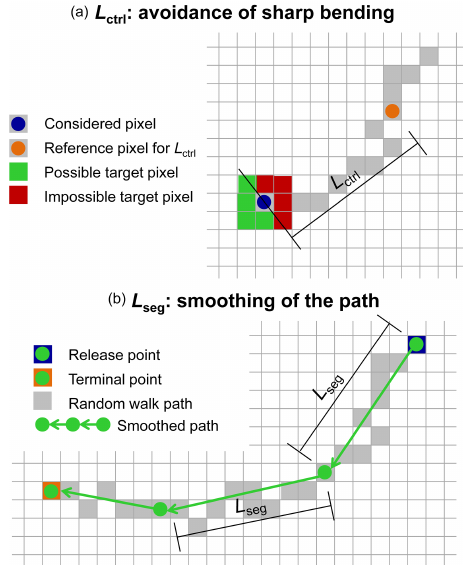
Figure 2. Control length L ctrl and segment length L seg . (a) Appli- cation of L ctrl to avoid sharp bending of the flow. (b) Smoothing of the flow path by introducing segments with maximum length of L seg